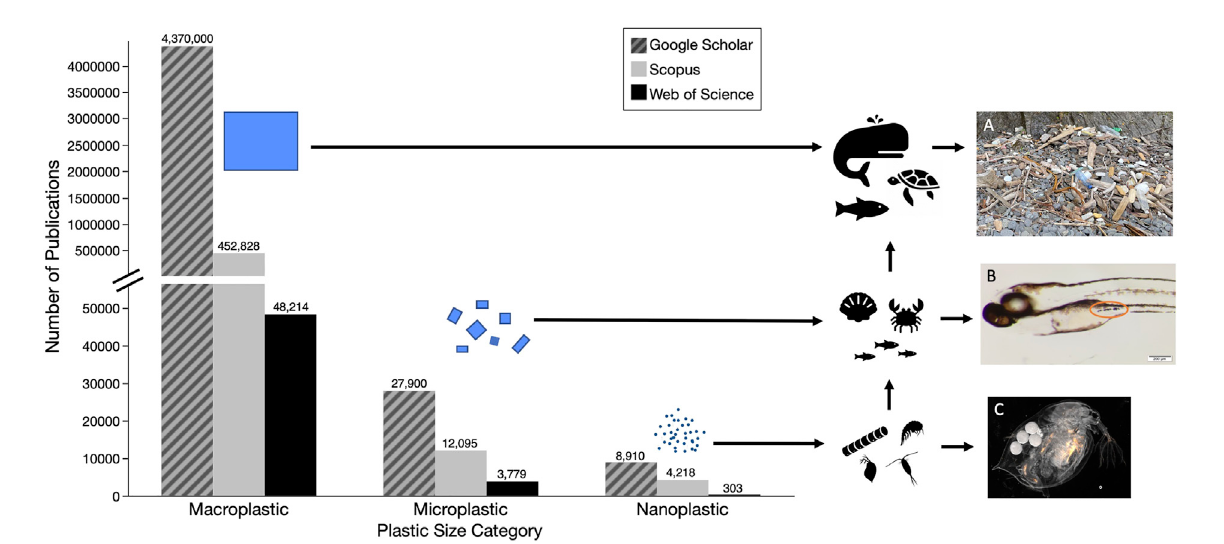
FIGURE 1 Numbers of papers on different size categories of plastic pollutants based on searches of three databases (i.e., Google Scholar — hatched grey, Scopus — grey, and Web of Science - black) (A) Macroplastic pollution washed up in the Katmai National Park, Alaska July 2021 (B) Exposed Zebra fi